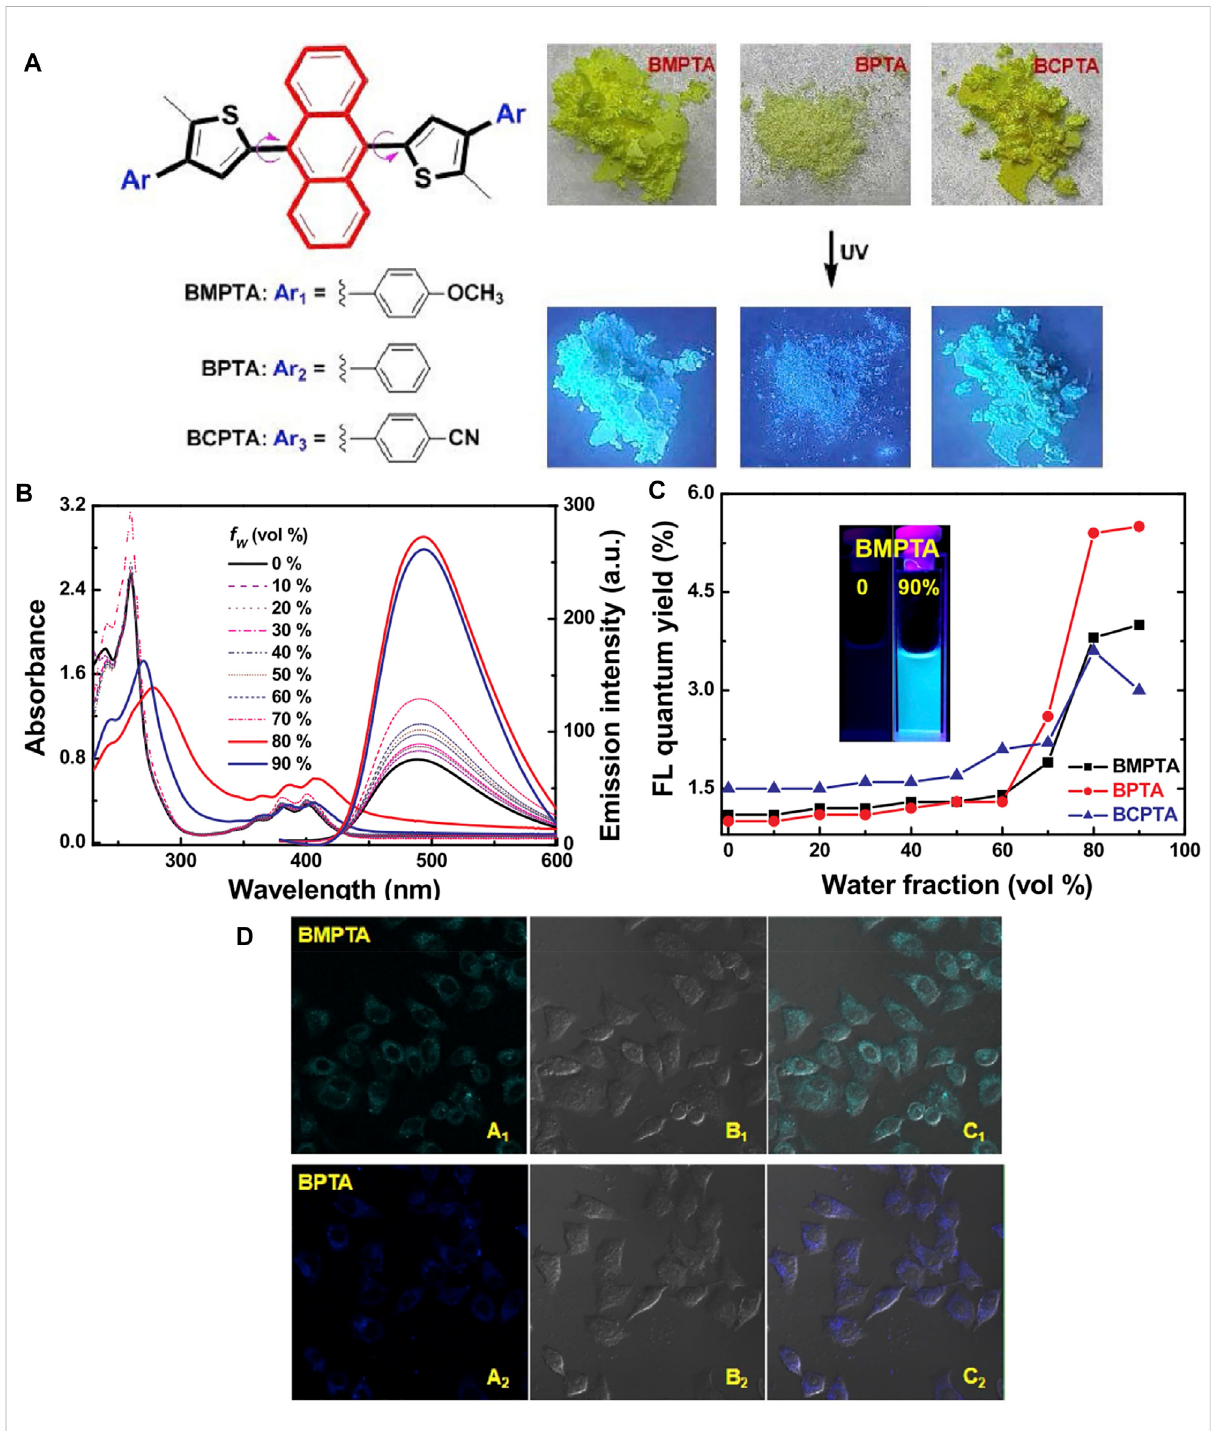
FIGURE 15 (A) Molecular structures of DTA derivatives and their photographic images under 365 nm UV light; (B) the absorption and fl uorescence spectra of BMPTA in THF/H 2 O with different fractions; (C) their changes in absolute fl uorescence quantum yield versus water fraction in THF; and (D) fl uorescent confocal microscopy images of HeLa cells stained with 20 μ M of BTA compounds for 30 min dark fi eld images, bright fi eld images, overlaid of dark and bright fi eld images (Wang R. et al.,